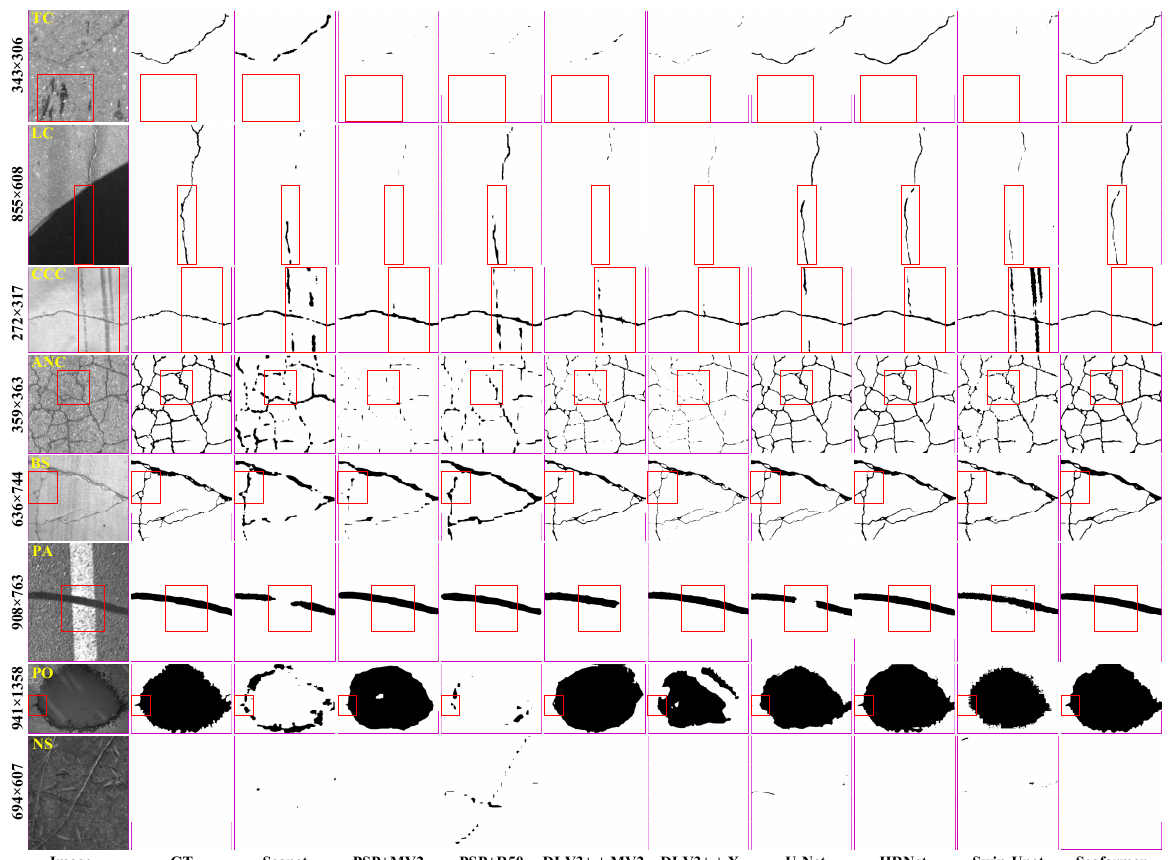
Figure 9. Segmentation results comparison for the seven classes of distress and distractors in complex scenes by the seven methods on the ISTD-PDS7 dataset. The red boxes in each image in the first row are the focus areas.